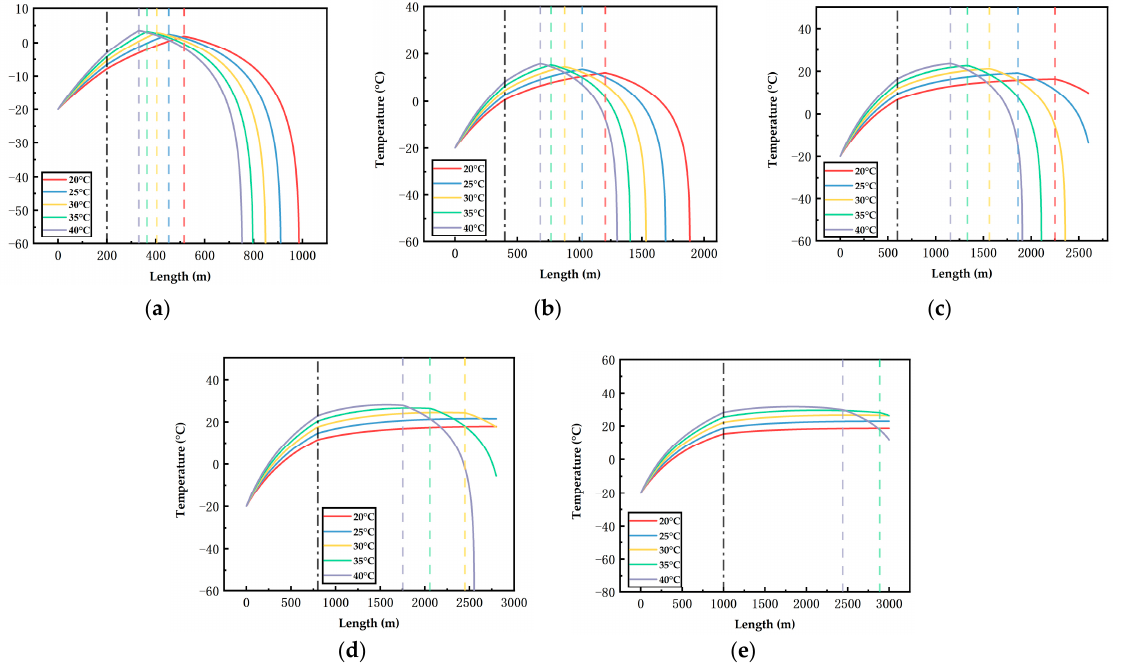
Figure 7. Variation of the on-way temperature with the length at 7.5 m/s airflow velocity, different ambient temperatures and depths (( a ) 200 m; ( b ) 400 m; ( c ) 600 m; ( d ) 800 m; ( e ) 1000 m). The black dotted line indicates the connection between the vertical pipe and the underground pipe; The dotted lines in other colors represent gasification